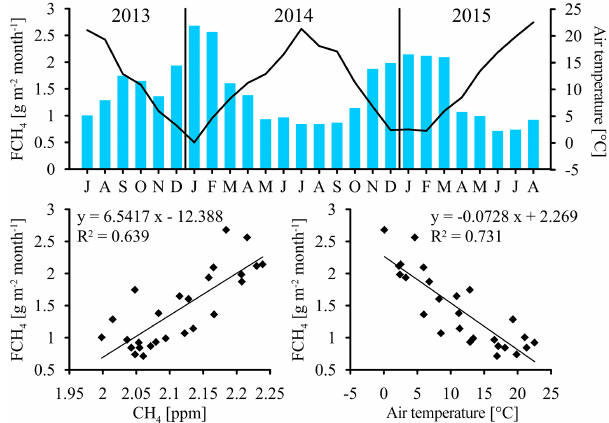
Figure 5. Monthly totals of FCH 4 (top) in relation to mean monthly CH 4 concentration (bottom left) and mean monthly air temperature (bottom right) in the period July 2013–August